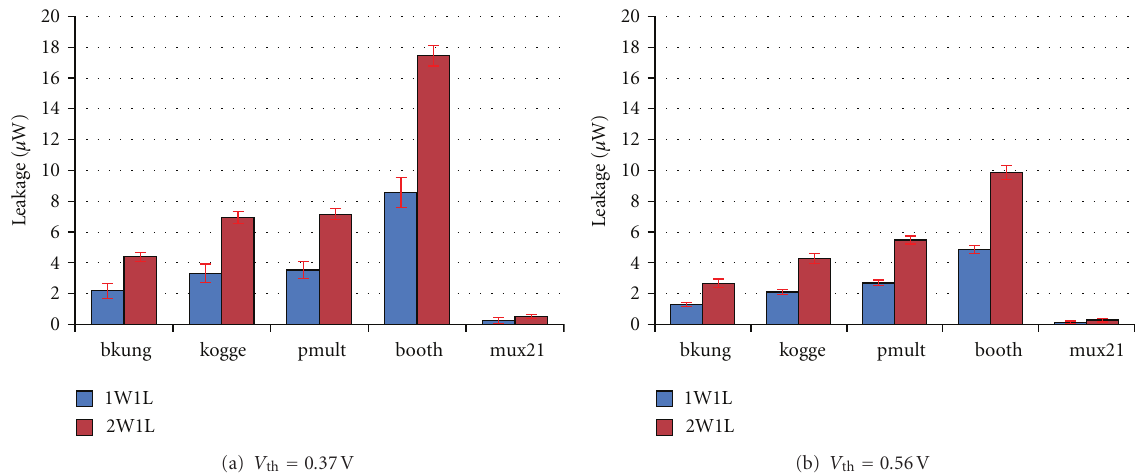
Figure 10: Leakage power characterization of function units with multi- V th /V dd and variation